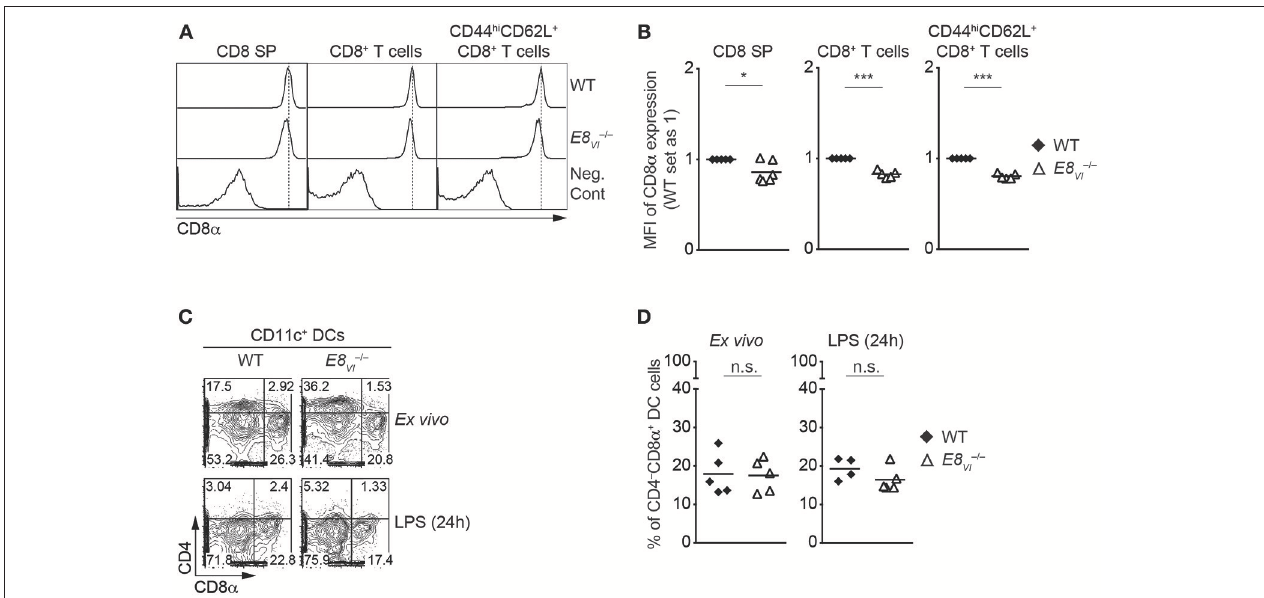
FIGURE 3 | Deletion of E8 VI leads to a reduction in CD8 expression in cytotoxic lineage cells. (A) Histograms showing CD8 α expression on CD8SP thymocytes, splenic CD8 + and CD8 + CD44 hi CD62L + T cells isolated from wild-type (WT) and E8 VI − / − mice. The gating strategy is shown in Figures S4B,C . Dotted vertical lines indicate the peaks of CD8 α expression on WT cells. CD8 α expression on WT CD4SP thymocytes (left panel) or CD4 + T cells (middle and right panels) is shown as negative staining control. (B) Diagrams showing the relative mean fluorescence intensity (MFI) of CD8 α expression on CD8SP thymocytes (left), splenic CD8 + (middle) and CD8 + CD44 hi CD62L + (right) T cells isolated from wild type (WT) and E8 VI − / − mice. The MFI values of WT cells were set as 1 for each experiment. Each dot represents one mouse. Horizontal bars indicate mean values. A one-sample t -test was performed for statistical analysis, where the values obtained from E8 VI − / − mice were compared to the WT ones (i.e., 1). The p -values were defined as following: *, p < 0.05; ***, p < 0.001. (C) Flow cytometry analysis showing CD8 α and CD4 expression on wild-type (WT) and E8 VI − / − splenic dendritic cells (DCs), which were either freshly isolated (upper panel) or stimulated with LPS for 24h (lower panel). The gating strategy for DCs is shown in Figure S4G . Numbers indicate the percentages within the respective regions. Data are representative of 4–5 mice analyzed in 4 independent experiments. (D) Diagrams showing the percentage of the CD4 − CD8 α + population within wild-type (WT) and E8 VI − / − splenic dendritic cells (DCs), which were either freshly isolated (left) or stimulated with LPS for 24h (right). Each dot represents one mouse. Horizontal bars indicate mean values. An unpaired Student’s t -test was performed for statistical analysis. n.s., not significant. Data are representative (A,C) or show the summary (B,D) of 5–6 mice (B) and 4–5 mice (B) analyzed in 5 (A,B) and 4 (C,D) independent